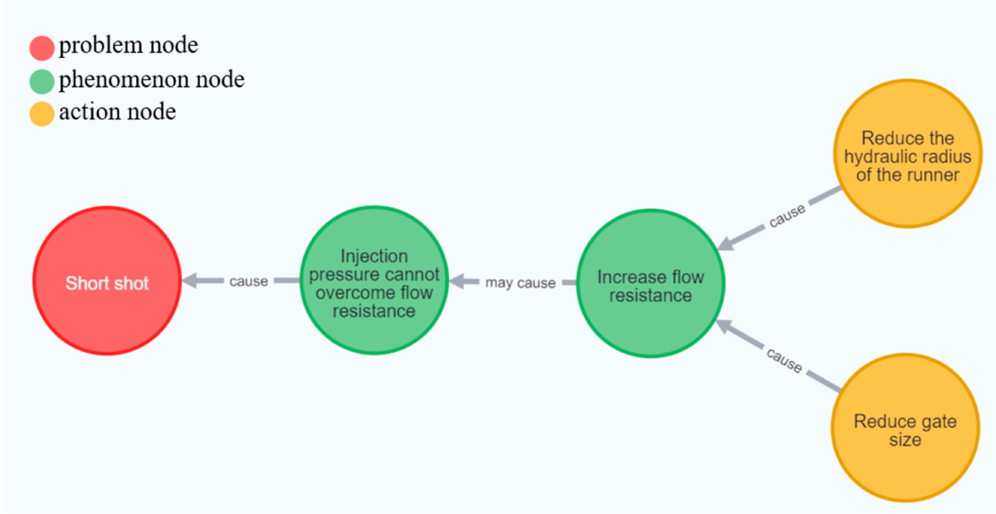
Figure 3. Action